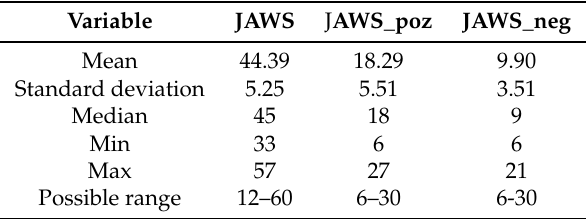
Table 2. Descriptive statistics of psychological